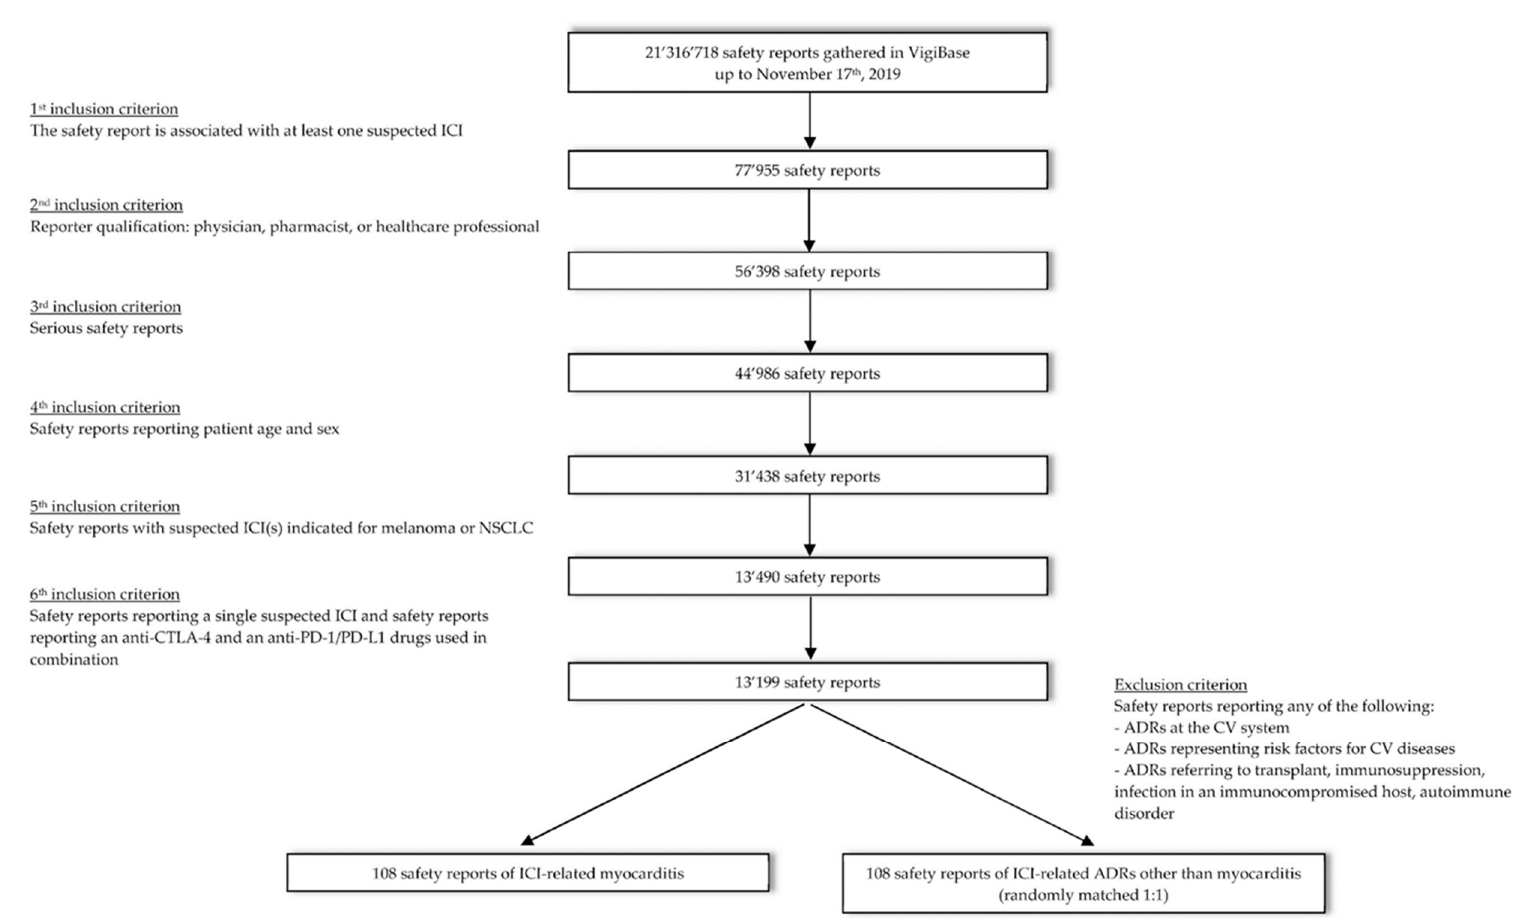
Figure 1. Consort diagram showing the multistep selection process applied to define the final dataset of safety reports eligible for the